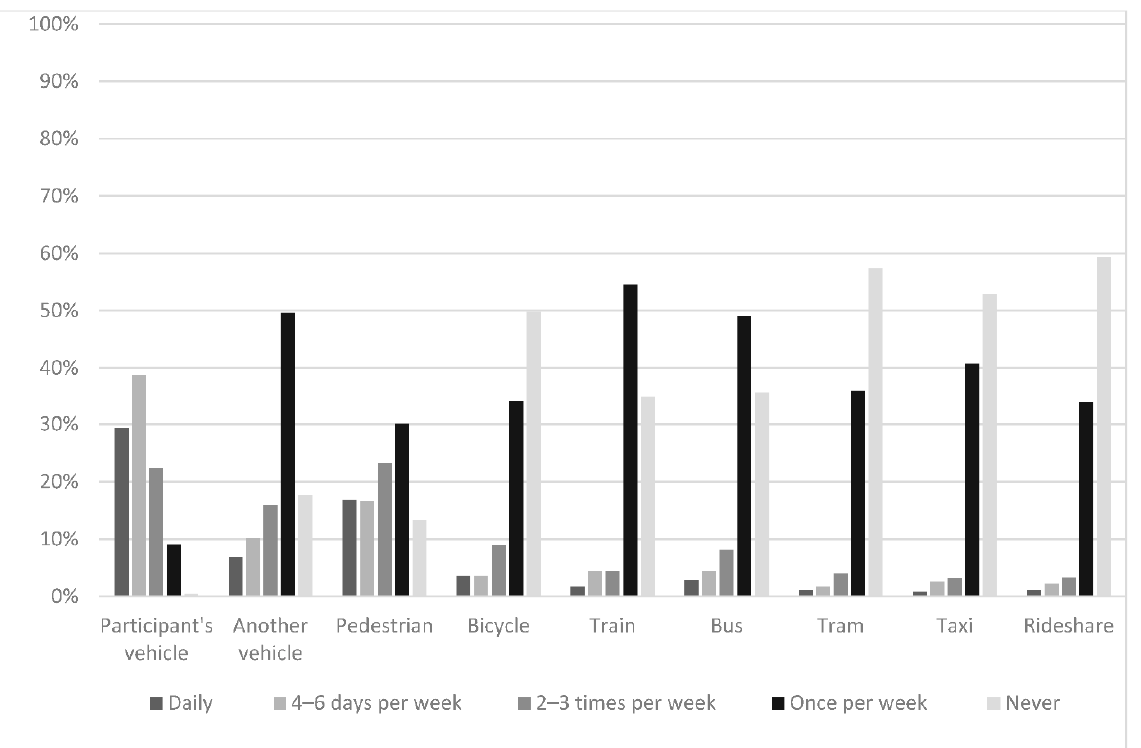
Figure 1. Participants’ use of different transportation modes with their youngest child.